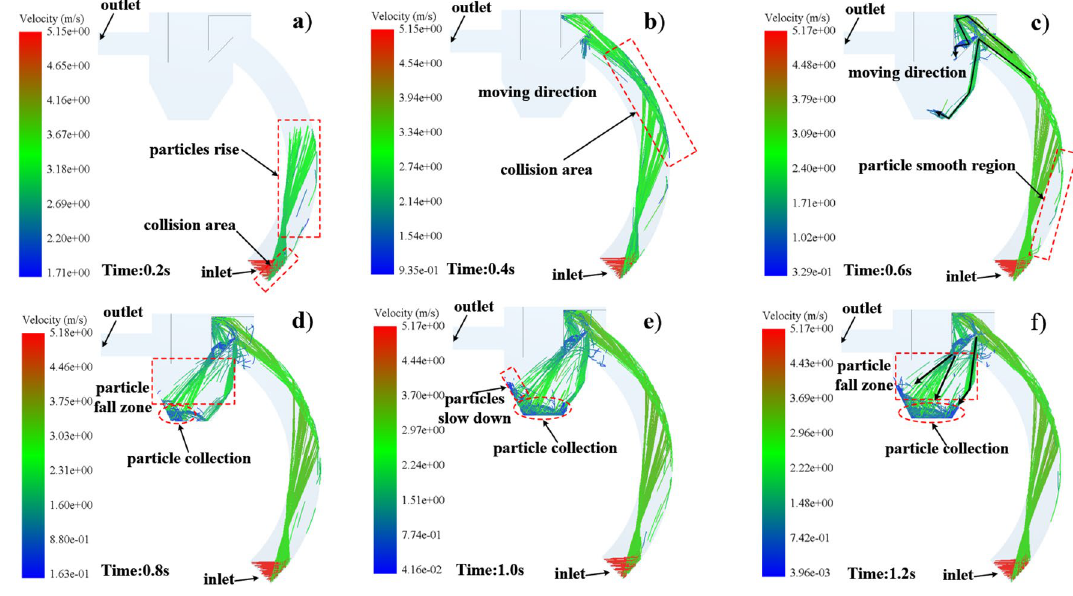
Figure 10. Steel shot particle motion